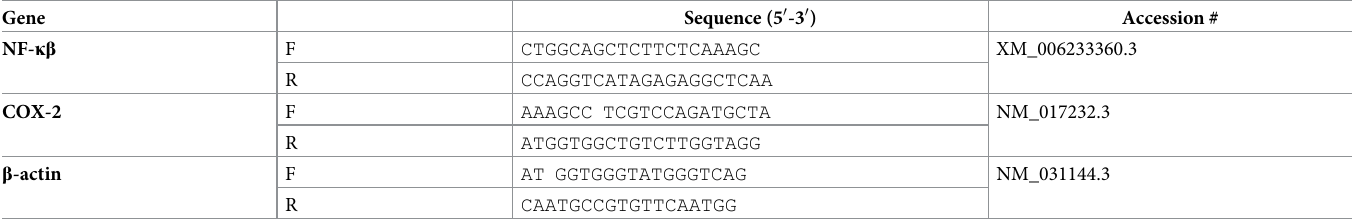
Table 1. List of “oligonucleotide primers” used in qPCR. Gene